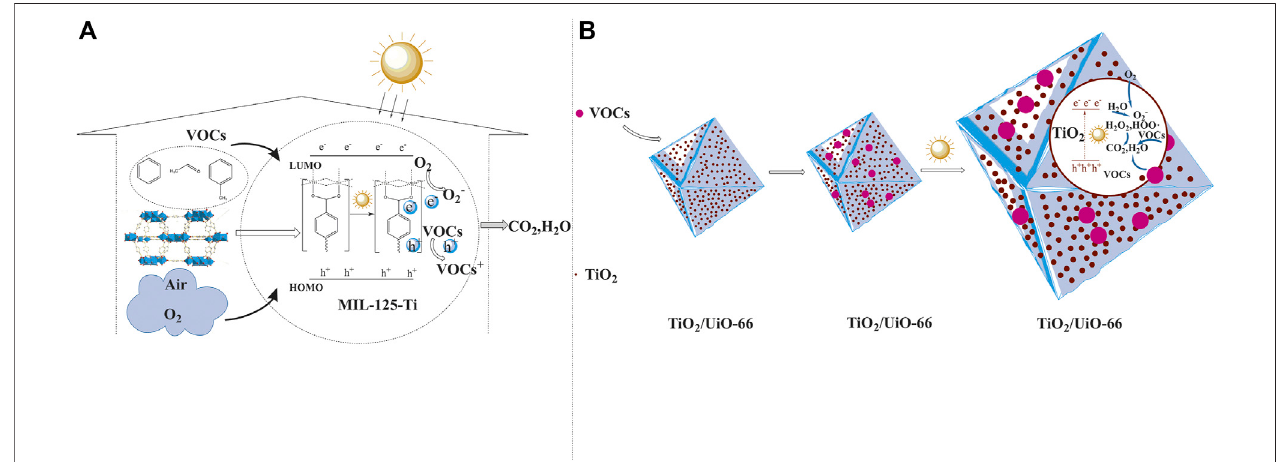
FIGURE 1 | Schematic representation of MOFs as direct photoactive center such as Mil-125-Ti (A) or as base material to combine other photoactive component such as TiO 2 /UiO-66-Zr (B) for degradation of indoor-air